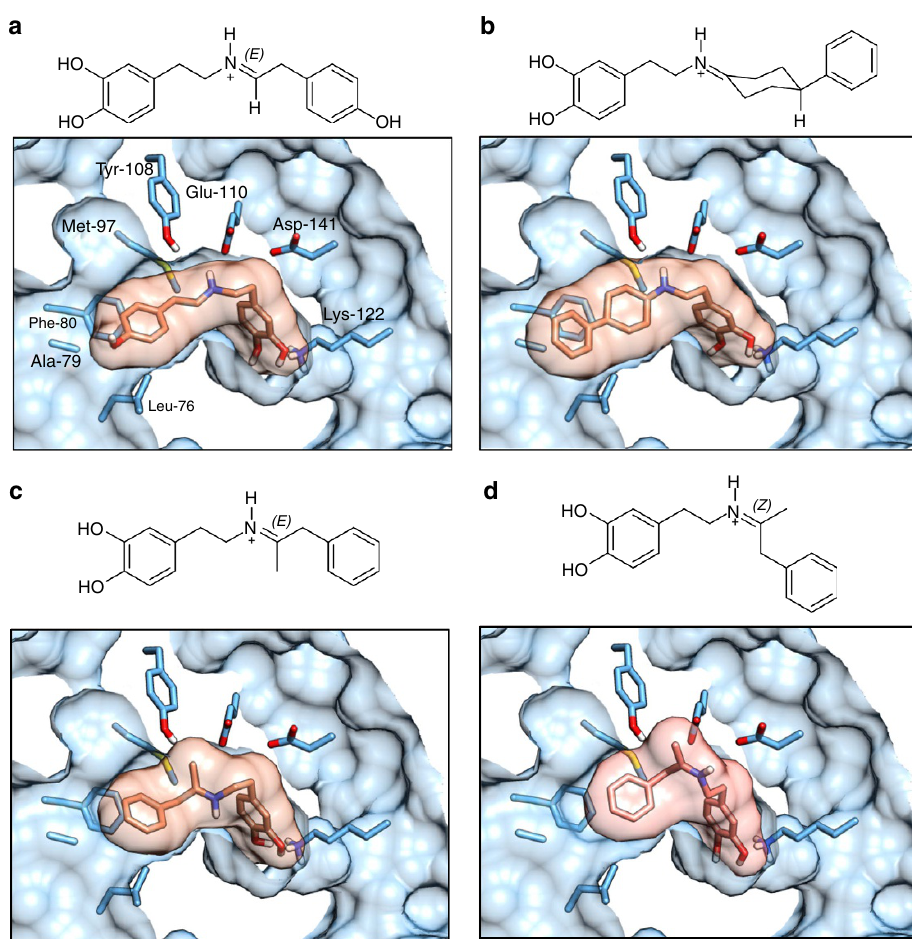
Figure 7 | Reaction intermediate binding modes. Iminium reaction intermediates were docked in the Tf NCS active site using AutoDock Vina 42 . The structure of the docked iminium ligand is shown above a depiction of the mechanistically relevant binding modes. The side chains of mechanistically important amino acids or amino acids modified in this study are shown as sticks. ( a ) Intermediate derived from 4-HPAA, the natural aldehyde substrate. ( b ) Intermediate derived from 4-phenylcyclohexanone 9 , a representative example of the docking results of cyclohexanone-derived compounds. ( c ) Intermediate derived from phenylacetone 4 with trans ( E ) double bond. ( d ) Intermediate derived from phenylacetone 4 with cis ( Z ) double bond. Complete docking results can be found in Supplementary Figs 7 and 8 and Supplementary Table